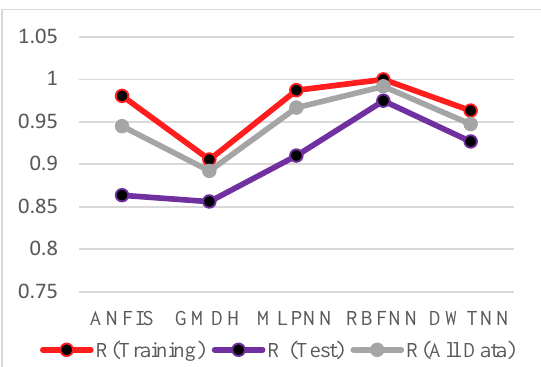
Fig. 19. Correlation between targets and